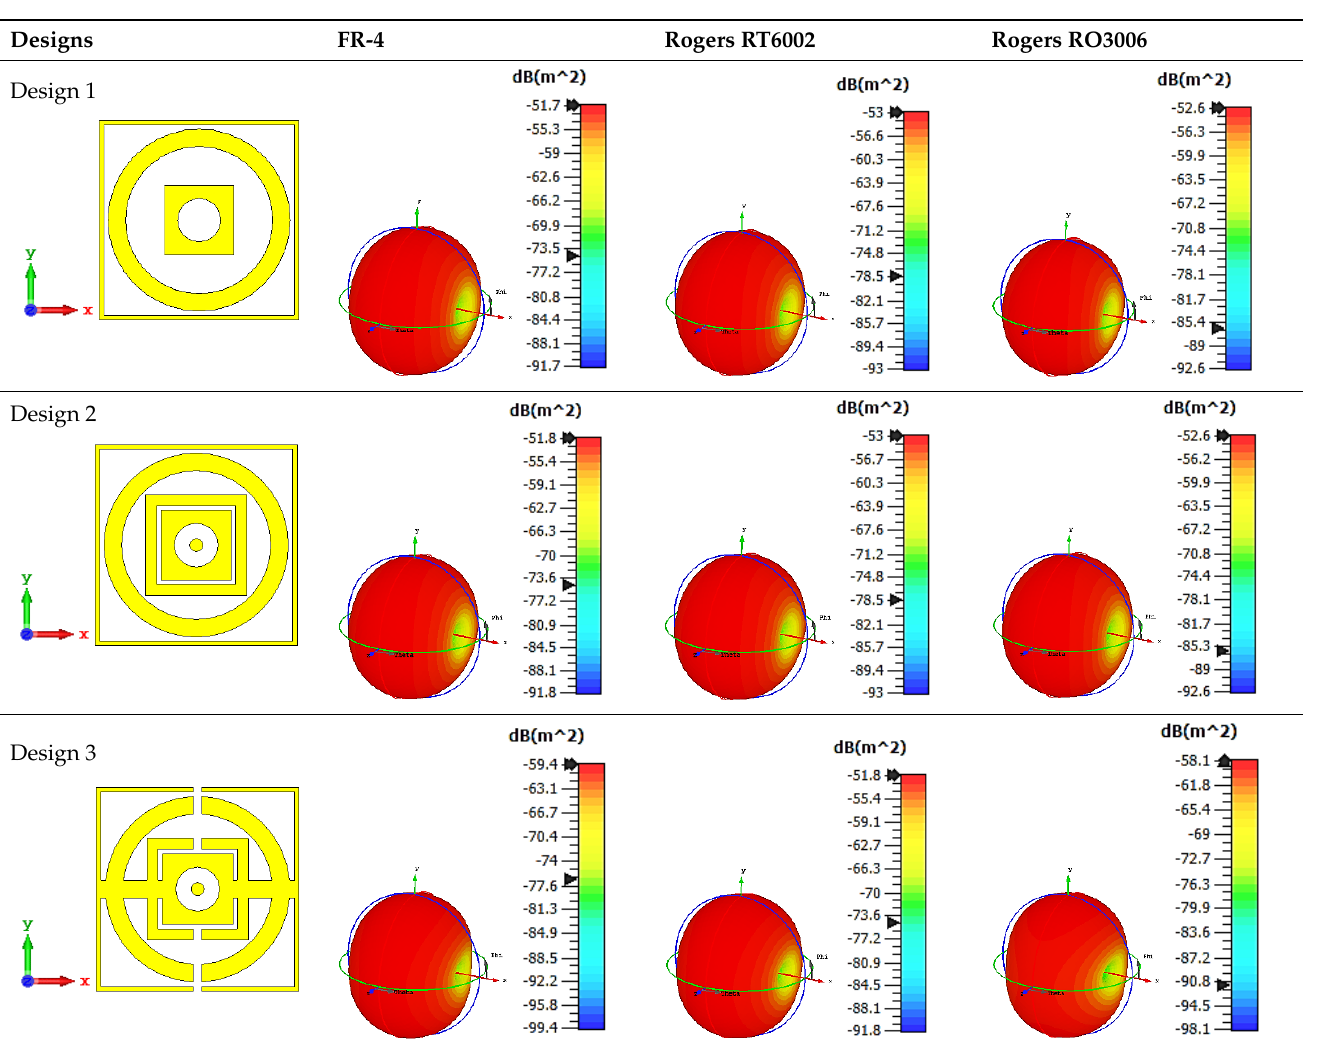
Table 4. Bistatic scattering patterns of uniquely shaped structure with the various substrate materials.